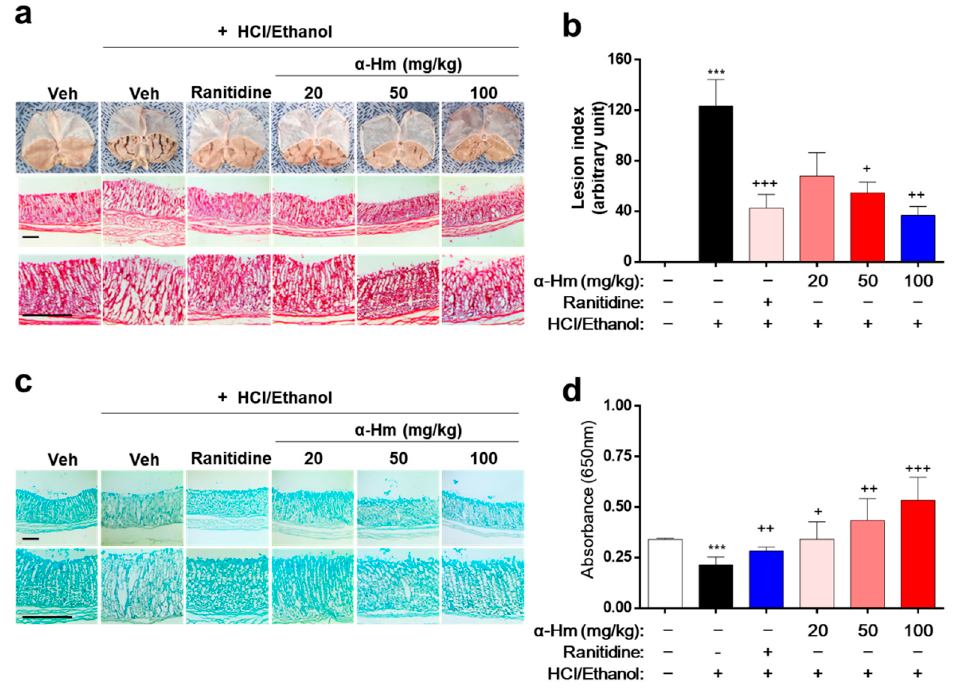
Figure 1. α -Humulene attenuates the mucosal lesions in HCl/ethanol-induced gastritis model. Either vehicle (Veh, Saline), α -humulene ( α -Hm, 20, 50, or 100 mg/kg) or 50 mg/kg ranitidine was orally administered before intragastric HCl/ethanol administration in rats. ( a ) Representative images of acute gastric damage and histological investigation by hematoxylin-eosin (H-E) staining of stomach sections. Scale bars are 0.5 mm. ( b ) Graphs showing the lesion index (arbitrary unit). ( c ) Representative pictures of Alcian Blue staining of mucus glands. ( d ) Quantification of Alcian Blue by measuring absorbance at 650 nm after solubilizing the stained tissues. + p < 0.05, ++ p < 0.01, +++ p < 0.001, *** p < 0.001. Table 1. Effect of α -humulene on the changes of gastric secretion volume and titratable acidity in pyloric ligation-induced gastric ulcers.